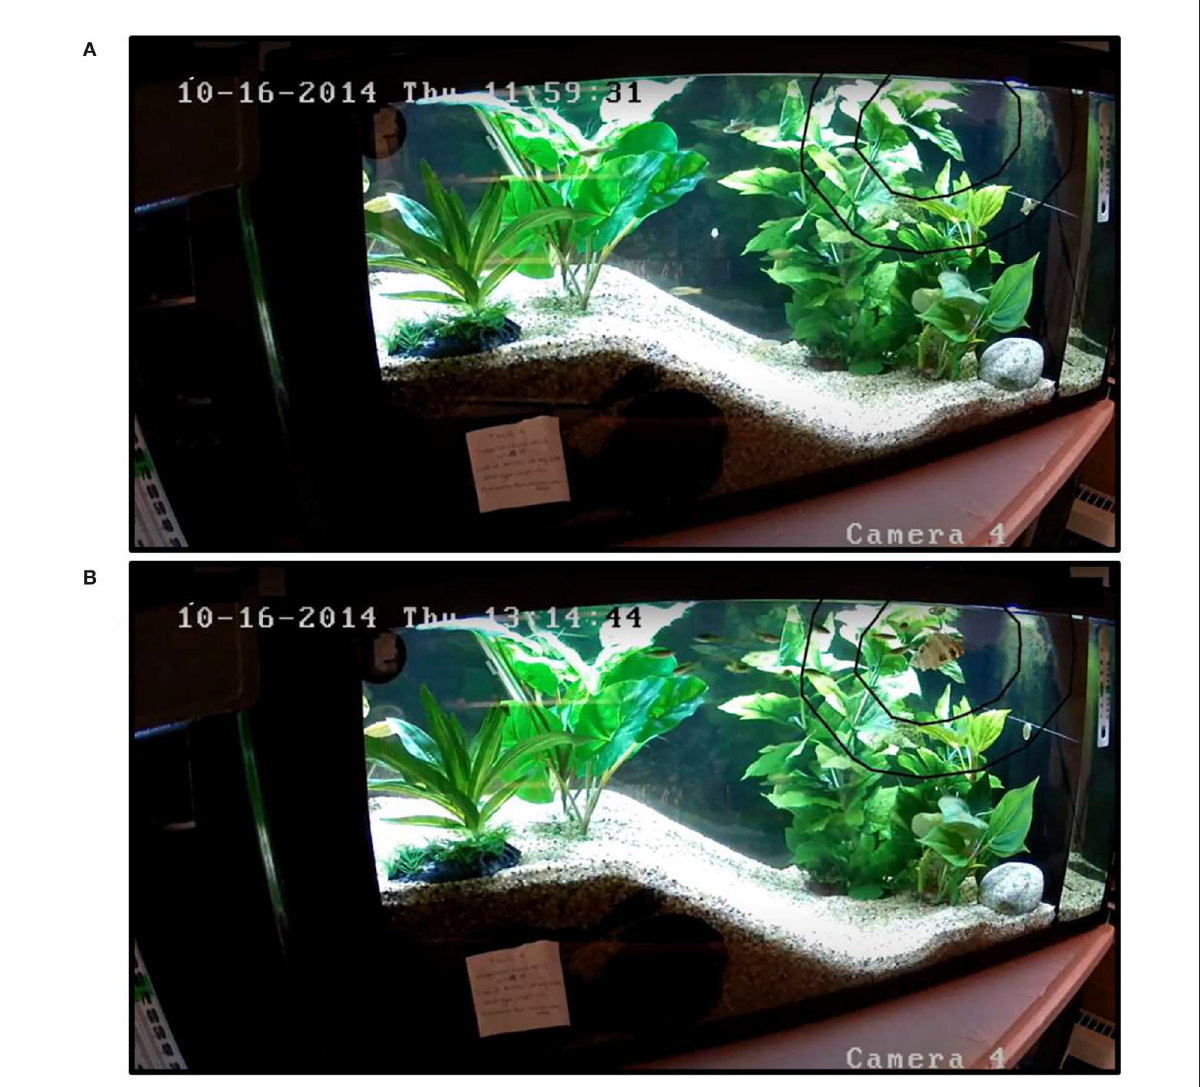
FIGURE1 Example zebrafish tank provided from stills of video data collected during (A) baseline and (B) corresponding object presentation. Two tanks were set-up with this orientation and four tanks were set-up in the reverse direction (slope on the right and deep-end/object presentation area on the left). The baseline period (A) was defined as at least 1h before a novel object was introduced into the tank. The concentric outlines around the object in panel (B) are overlain on both videos to indicate the areas within approximately two zebrafish body-lengths from the object and four zebrafish body-lengths from the object. Fish presence in the inner area (two body-lengths) was used for the analyses. Each object-tank combination had its own outline to control for differences in object size and shape so that interest scores could be calculated as the number of fish in the inner area beyond the number observed during baseline: interest score = fish in inner area object presentation – fish in inner area baseline